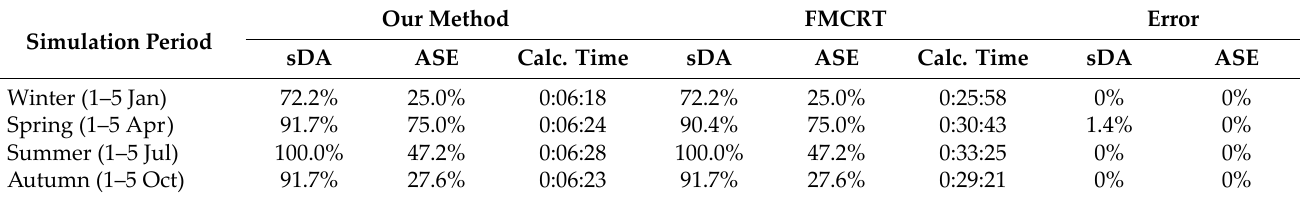
Table 3. Comparison of our method with FMCRT. The first verification scene (Figure